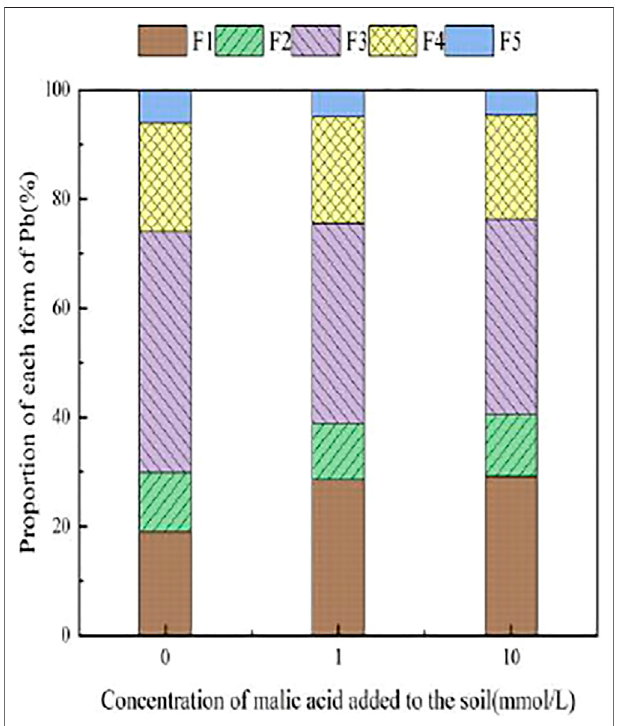
FIGURE 11 | Distribution of Pb form in soil after adding malic acid and Pb-800 soil after adding malic acid.